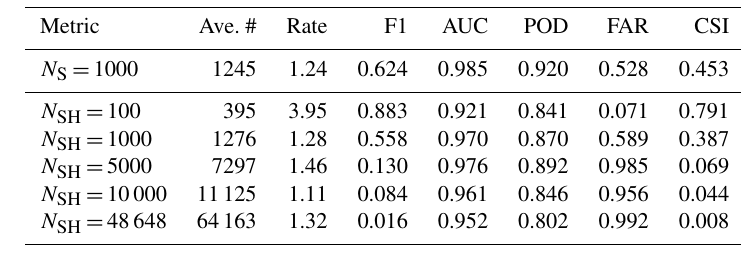
Table 2. The average number of predicted particles divided by the number of planes N , and the computed binary metrics for the mask prediction task, are listed for each model. The metrics were computed using the 10 test holograms, where each hologram contained 500 particles.